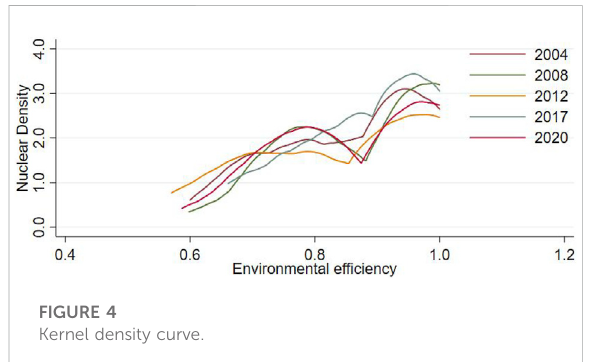
FIGURE 4 Kernel density